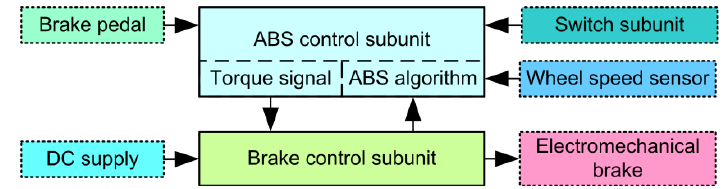
Figure 6. Block diagram of ABS and brake control subunits.